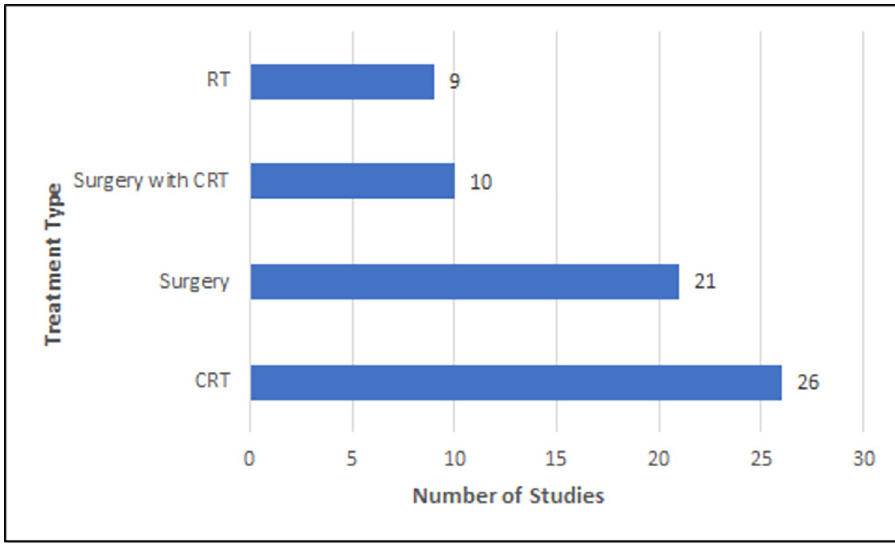
Fig 4. Participant details (treatment